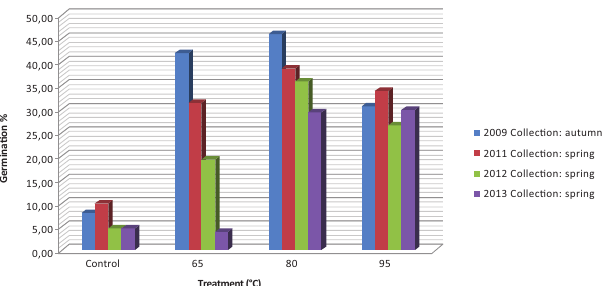
Figure 1: Influence of hot water treatment on germination( %) of Sida h.